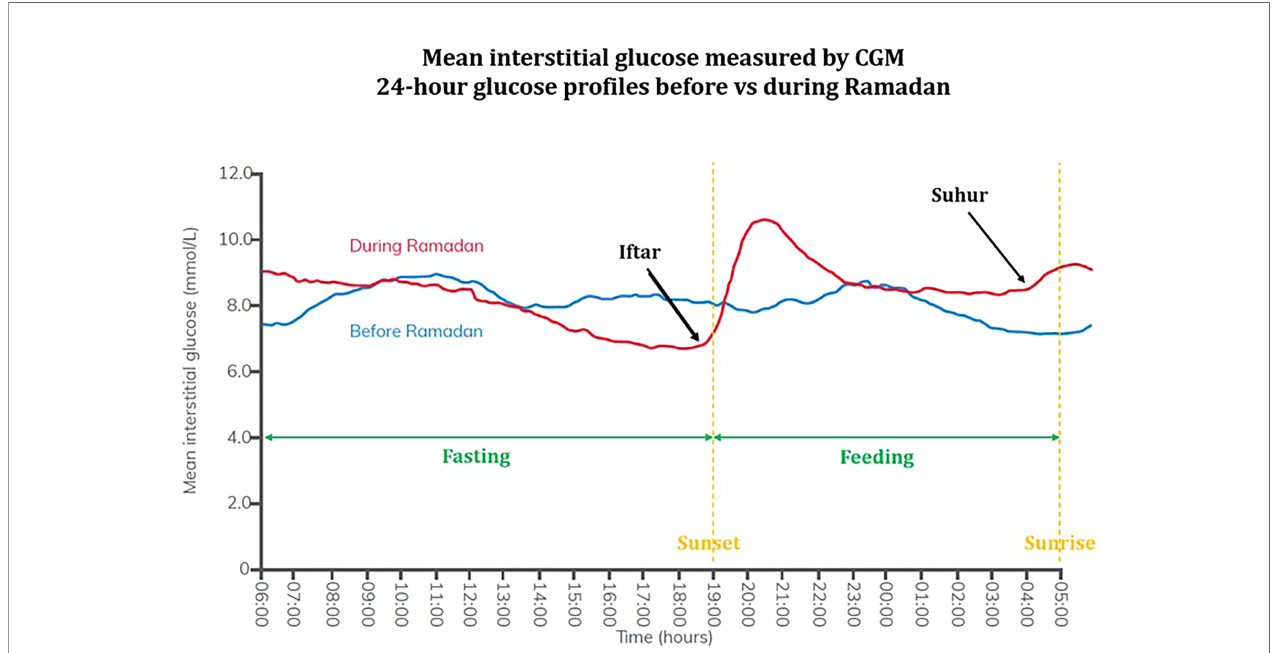
FIGURE 2 | Mean interstitial 24-hour glucose pro fi le measured by CGM in patients with type 2 diabetes before and during Ramadan. Adapted from International Diabetes Federation (IDF) 2021 guidelines on management of diabetes during Ramadan. Written permission obtained by Professor Mohamed Hassanein and Professor Bachar Afandi, lead authors of the IDF 2021 guidelines. Continuous glucose monitoring (CGM) data was obtained from patients with type 2 diabetes (n = 54) before Ramadan (blue) and during Ramadan (red). Fasting and feeding periods (green) as well as sunset and sunrise times (yellow) are indicated. Average interstitial glucose concentrations were similar between periods before and during Ramadan. Greater glycemic variability was demonstrated during Ramadan with nadir in BGLs pre-Iftar followed by peak post-Iftar, with second smaller rise